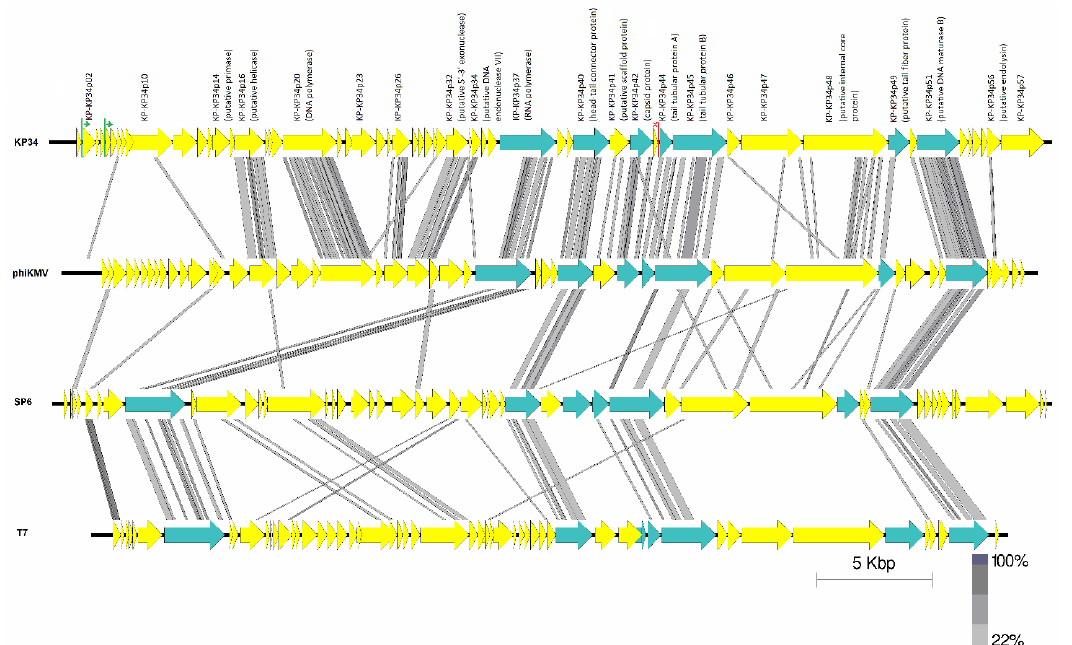
Figure 3. Pairwise comparison using tblastx of the four type phages KP34, φKMV, SP6 and T7. Lines between genomes represent high amino acid similarity between the phages using tblastx analysis. Blue arrows denotes conserved genes across the Autographivirinae subfamily. Green lines show putative phage specific promoter sites and red rho-independent terminator in phage KP34. Table 4. Conserved genes among phages within the “Kp34likevirus” and their amino acid pairwise identity to phage KP34. Conserved genes between KP34 and φKMV shown in bold. a : a.a. query coverage range from 84.7%–85.04%. b : a.a. query coverage range